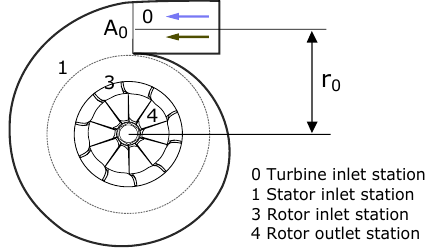
Figure 14. Geometrical description for calculating the flow angle in vaneless twin-entry/dual-volute turbines.